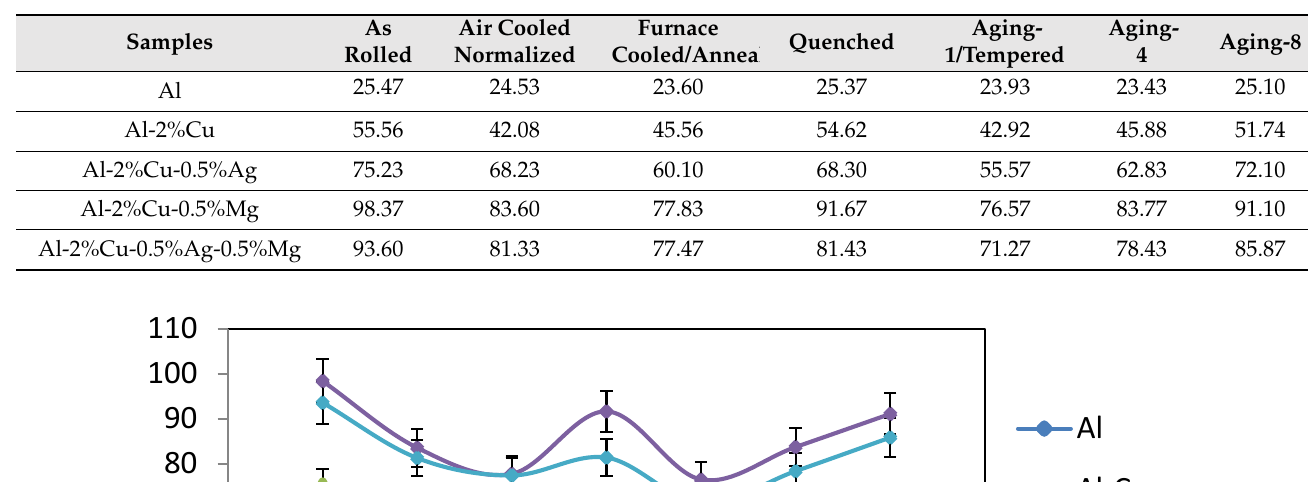
Table 2. Hardness (HV) values of different heat-treated alloys.